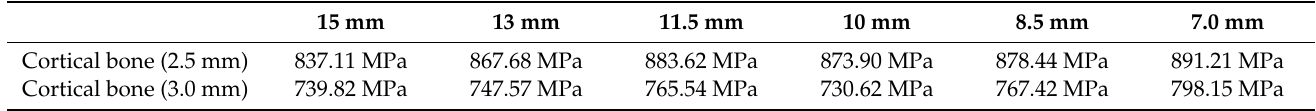
Figure 11. Cortical bone/hole in bone von Mises stress value charts (axial). Table 5. Cortical bone, Hole of bone 2.5 mm/3.0 mm (oblique force) von Mises stress values.